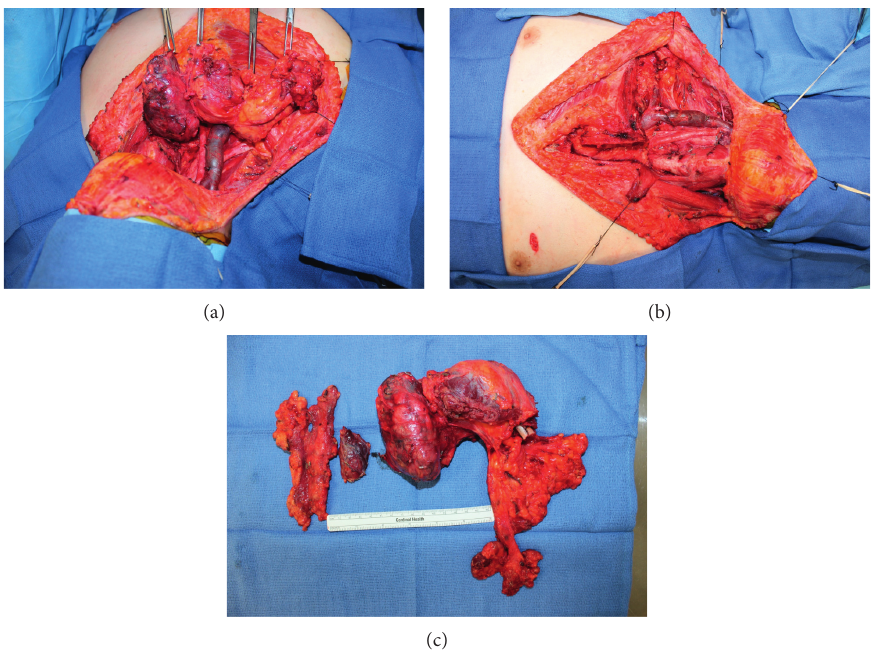
Figure 4: (a), (b) Retracted and removed gross pathology of the PTC mass. (c) Gross pathology of the resected neck mass.